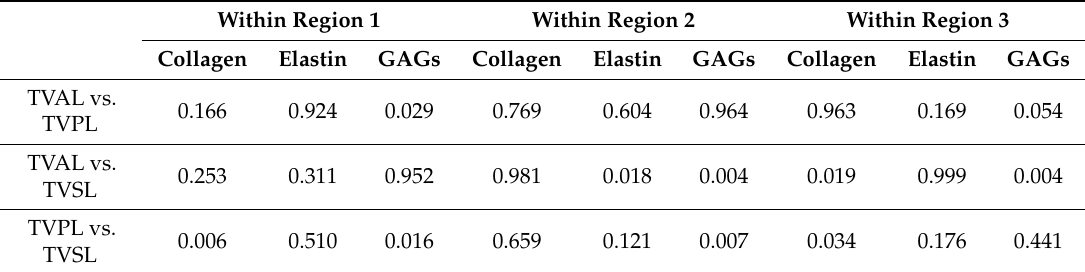
Table 4. Statistical comparisons ( p -values) of the constituent mass fraction between any two TV leaflets, regarding the three regions for the representative heart #1 (see Figure 1d). Within Region 2